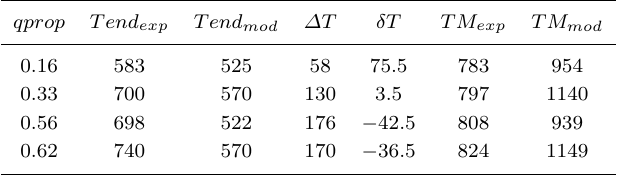
Table 5. Values of qprop [l/min], Tend exp [ K ] ,Tend mod [ K ], ∆T,δT,TM exp ,TM mod qprop Tend exp Tend mod